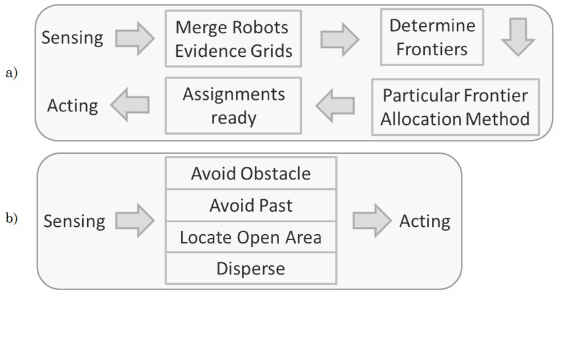
Figure 3. Comparison between: ( a ) popular literature exploration process and ( b ) our proposed exploration. Clear steps and complexity reduction can be appreciated between sensing and